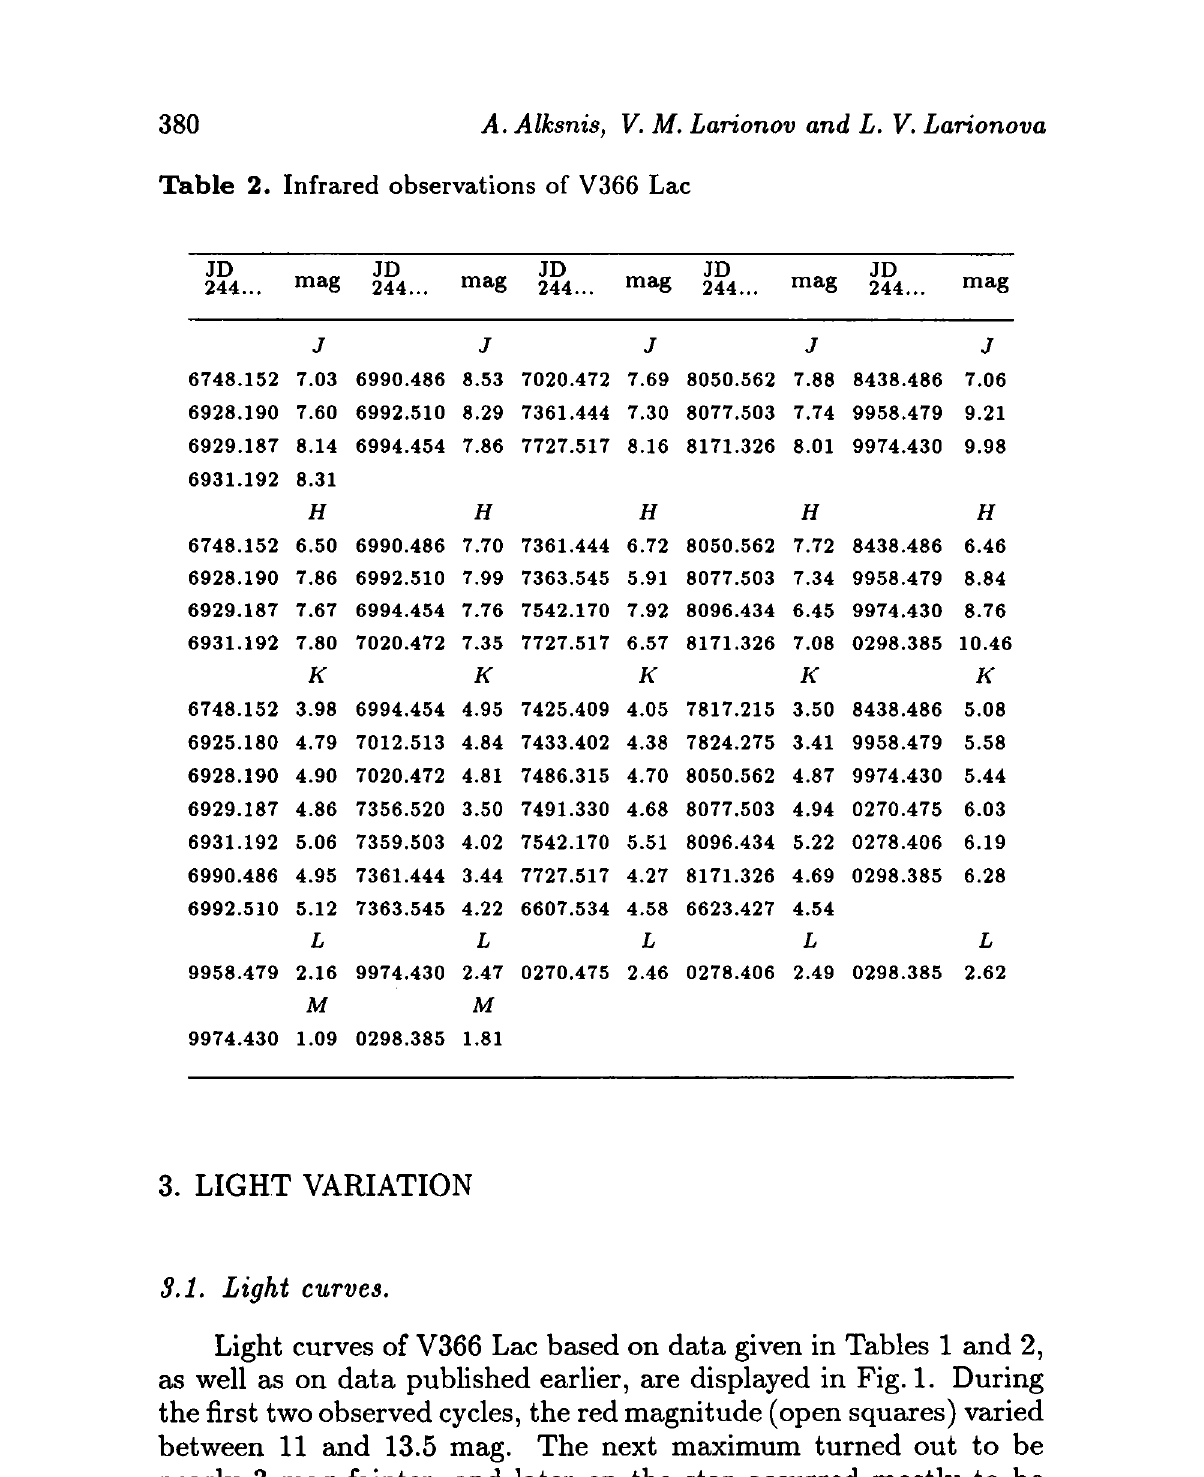
Table 2. Infrared observations of V366